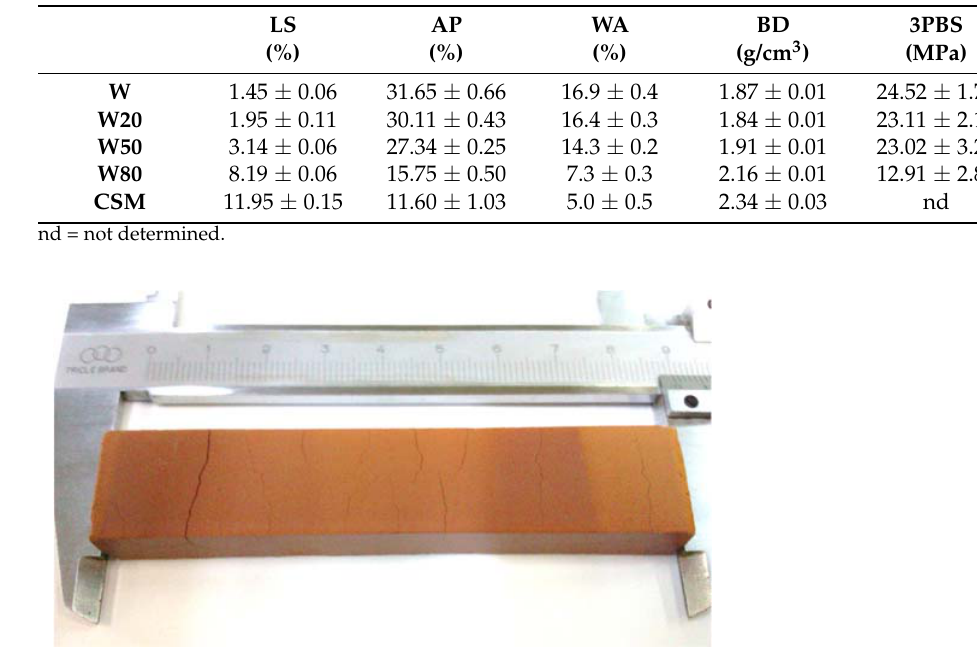
Figure 5. Fired sample consisting only of CSM (100 wt%). Visible cracks appear on the surface.